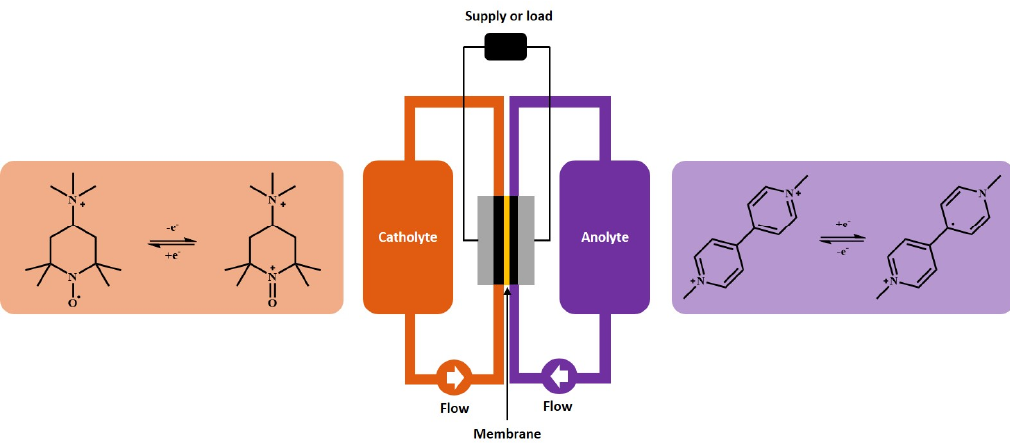
Figure 2. Schematic representation of the working principle of a redox flow battery employing solutions of TMA-TEMPO and MV. Chloride is used as a counter ion.